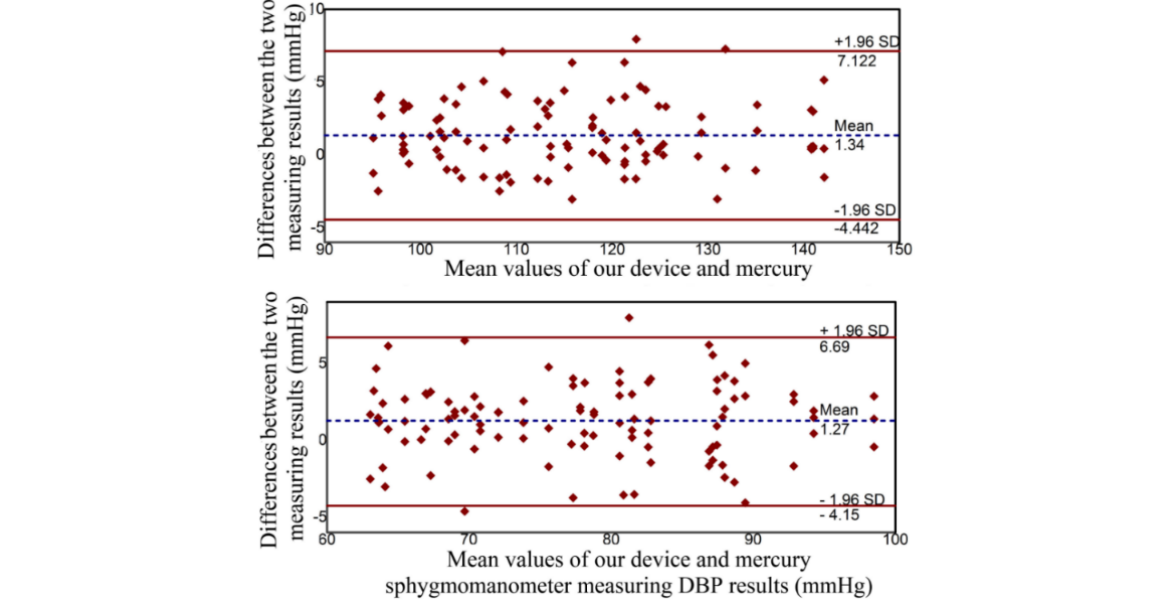
Figure 5. Agreement analysis between our device and the sphygmomanometer using a Bland and Altman plot. DBP: diastolic blood pressure.